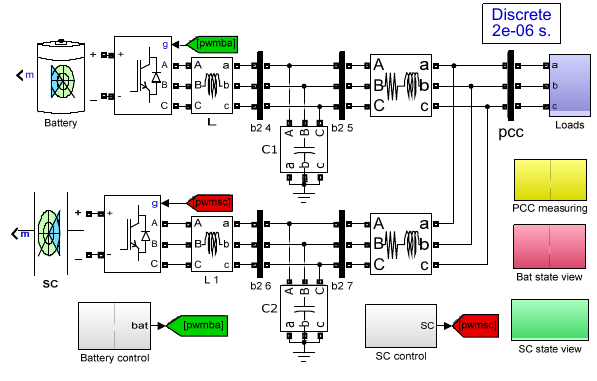
Figure 9. The simulation model block diagram of HESS.